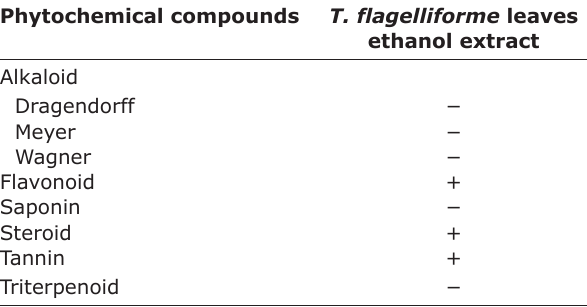
Table-1: The phytochemical screening of T. flagelliforme leaves ethanol extract. Phytochemical compounds